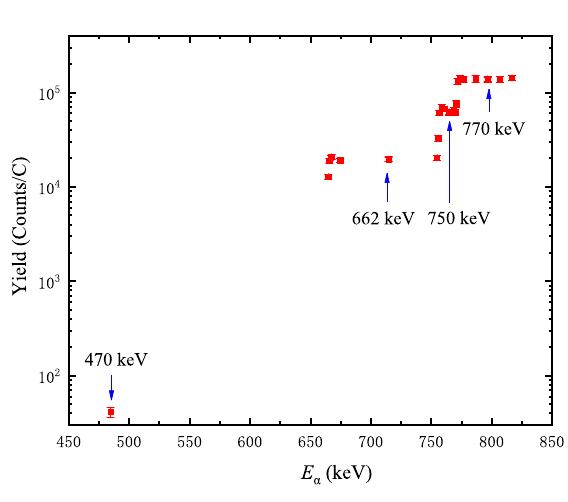
Figure 3: Yield of the 470, 662, 750 and 770 keV resonances of 18 O( α, γ ) 22